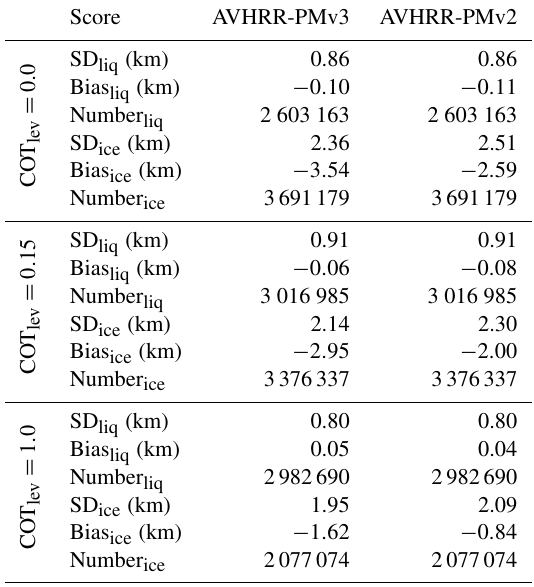
Table 3. Cloud phase (CPH) validation results for Cloud_cci AVHRR-PMv3 when compared with CALIOP. Validation results for AVHRR-PMv2 are also reported. Validation measures are Hei- dke skill score (HSS), hit rate, the probabilities of detecting liquid and ice phase (POD liq , POD ice ), and bias of liquid cloud occur- rence. In addition the number of collocated pixels is given. The scores are separated into two cloud optical depth levels (COT lev ) representing the top-down COT into the cloud at which the refer- ence CALIOP CPH was taken.